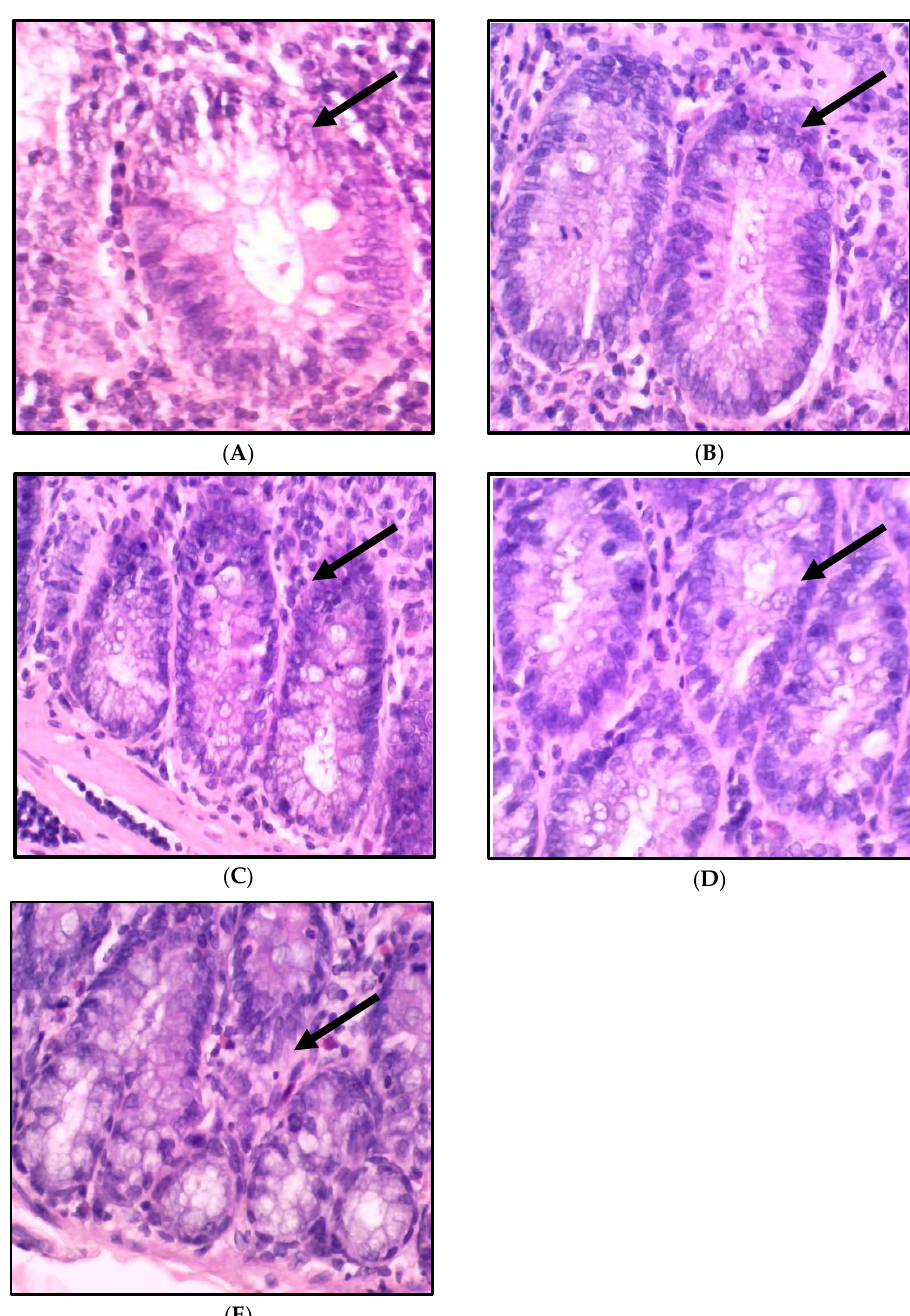
Figure 4. Histology classification of colon ACF types stained with haematoxylin and eosin (magni- fication, ×10): ( A ) one crypt, ( B ) two crypts, ( C ) three crypts, ( D ) four crypts, ( E ) and five or more crypts. The black arrow indicates the aberrant crypt foci.